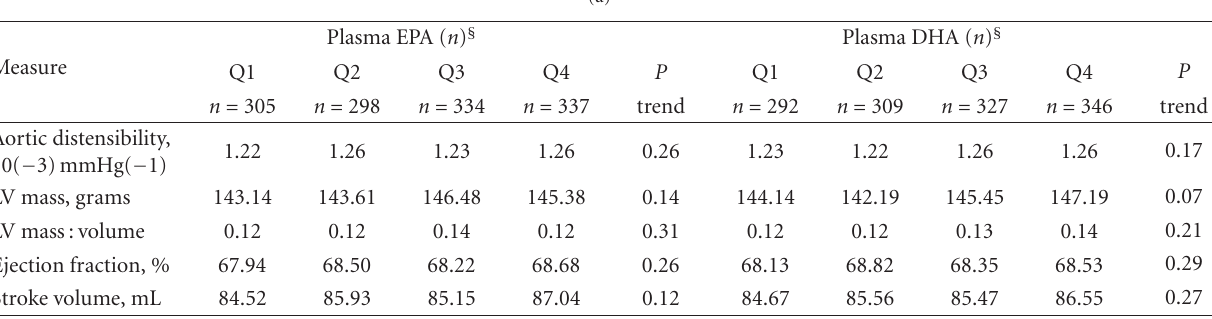
Table 3: (a) Relation between plasma phospholipid omega-3 fatty acid levels and measures of cardiac structure and function. ‡ , ∗ (b) Relation between plasma phospholipid omega-3 fatty acid levels and measures of cardiac structure and function. ‡ , ∗